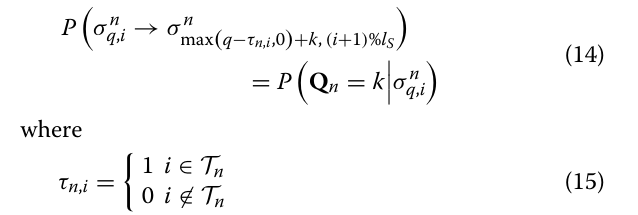
slots. Furthermore, % denotes the modulo operation.